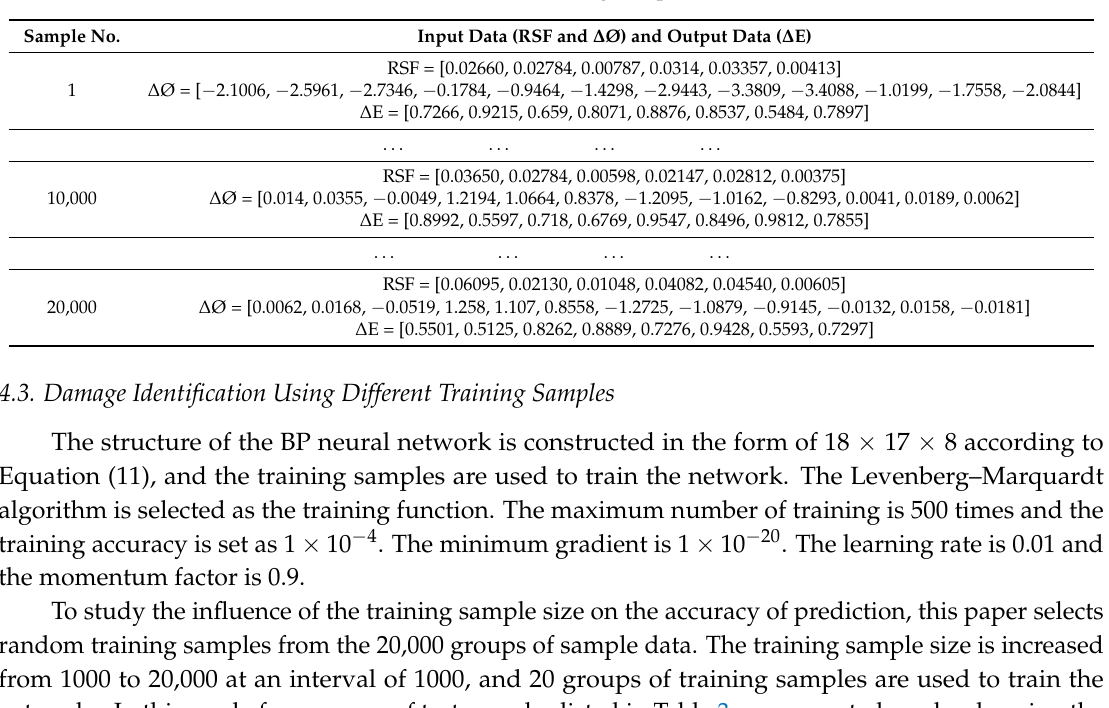
Table 2. Selected training sample